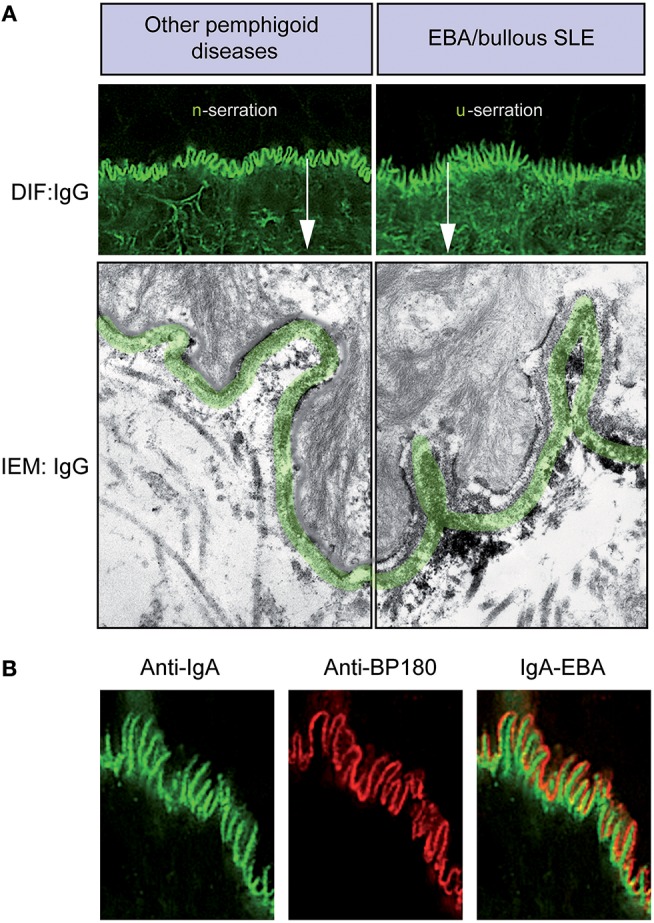
Diagnosis of EBA by direct immunofluorescence. (A) All pemphigoid variants are characterized by linear deposition of immunoglobulins and/or complement along the epidermal basement membrane zone. Serration pattern can be separated in an n-serrated pattern (blistering diseases with binding above the lamina densa with antibodies against hemidesmosomal components, e.g., BP, pemphigoid gestationis, mucous membrane pemphigoid, anti-p200 pemphigoid, and anti-laminin 332 pemphigoid, exept MM-EBA) and a u-serrated pattern (sublamina densa binding diseases caused by autoantibodies against COL7, e.g., EBA and bullous SLE). (B) In some cases, it is not possible to determine the serration pattern, especially in mucosal biopsies. In these cases, the level of the deposition of antibodies can be determined by fluorescent overlay antigen mapping (FOAM). FOAM is a technique that is based on the possibility of visualizing a targeted antigen relative to a topographic marker. For instance, using red staining, it is used for BP180 as a topographic reference marker, and green staining is used for IgA deposits. In the case of IgA-EBA, separate patterns of IgA deposits (green) and BP180 (red) can be observed with red staining on the dermal side.